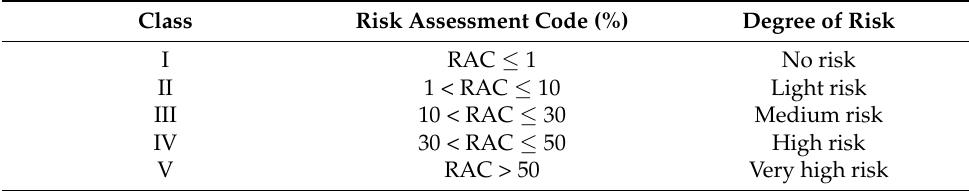
Table 1. Risk Assessment Code